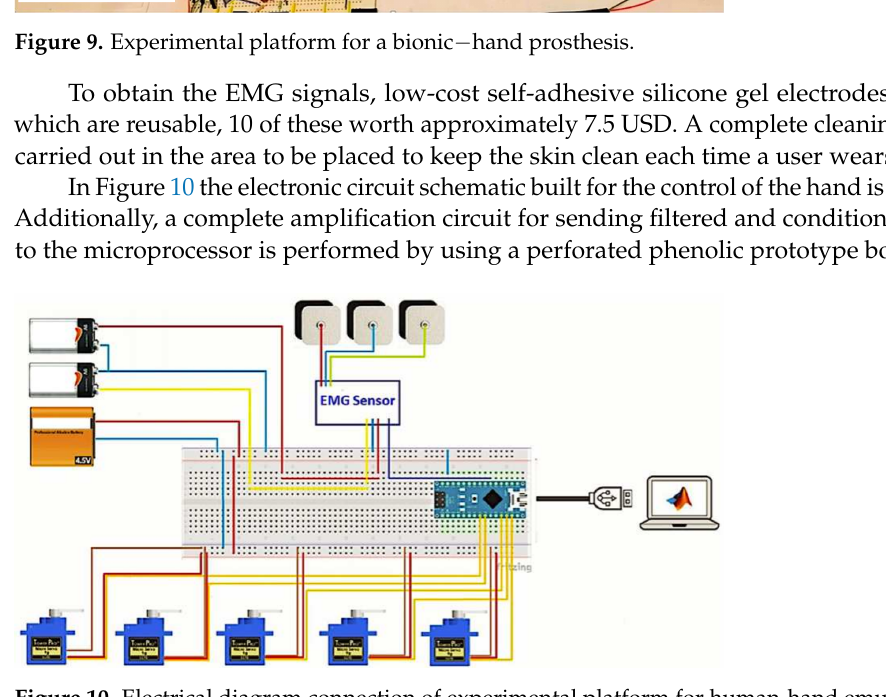
Figure 10. Electrical diagram connection of experimental platform for human-hand